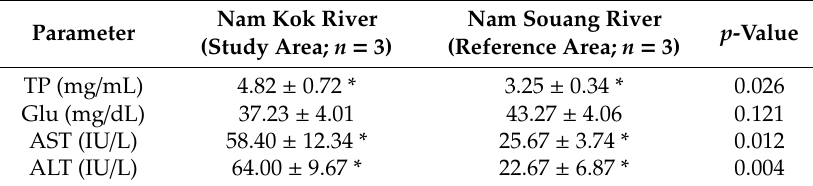
Table 7. Serum enzyme parameters of O. vittatus from the Nam Kok river near the Sepon gold-copper mine as the study area and the Nam Souang river as the reference area.